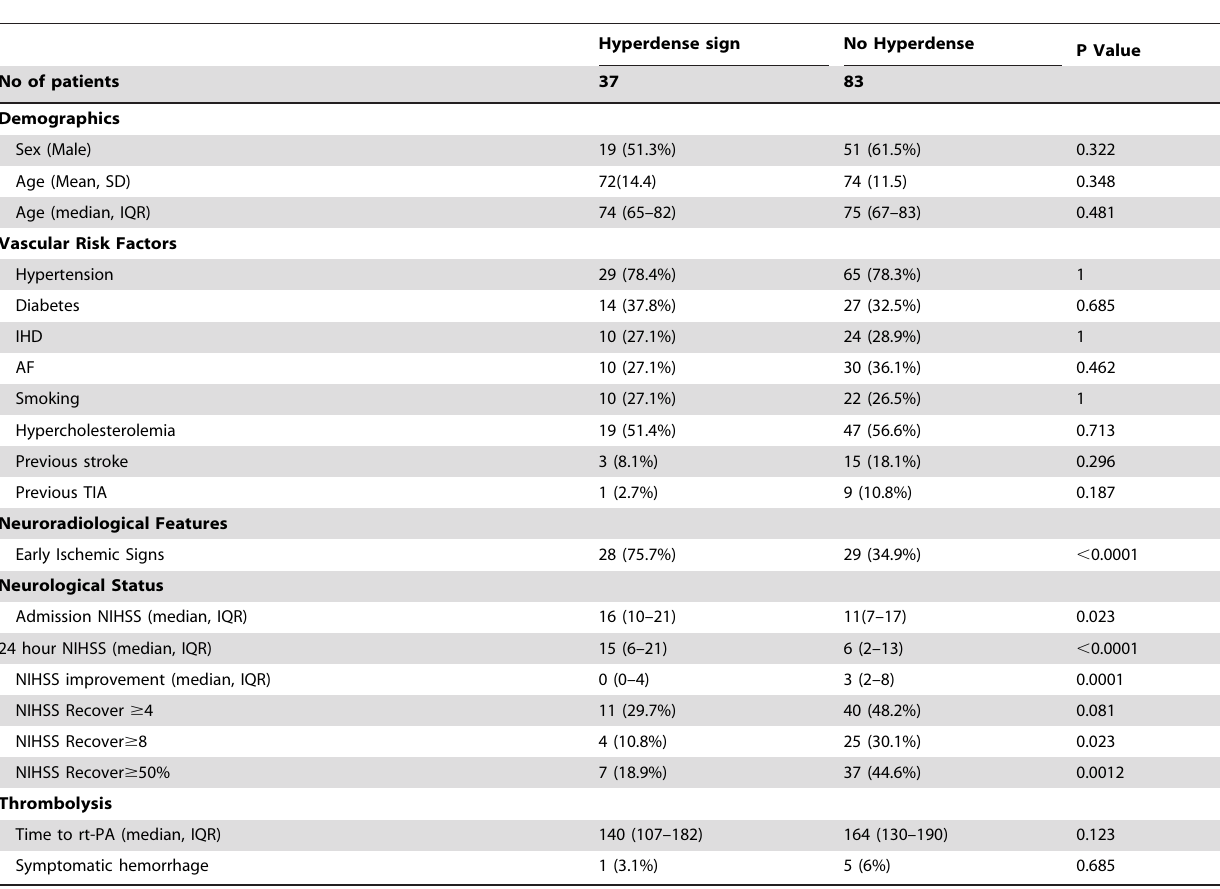
Table 1. Baseline data and response to rt-PA between patients with hyperdense artery sign and those without the